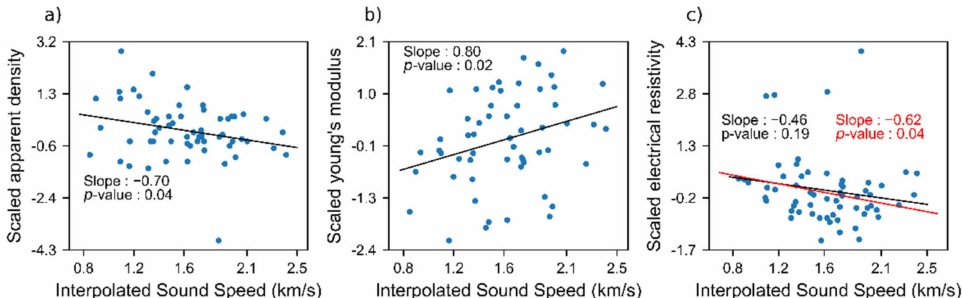
Figure 12. Linear regression results between the anode properties measured on core samples and the average interpolated speed of sound in the vicinity of the extracted core positions for ( a ) Apparent density, ( b ) Young’s Modulus, and ( c ) Electrical resistivity. The slopes, as well as their p -values, are indicated in the plots. In ( c ), the red data refer to the correlation obtained after excluding the farthest